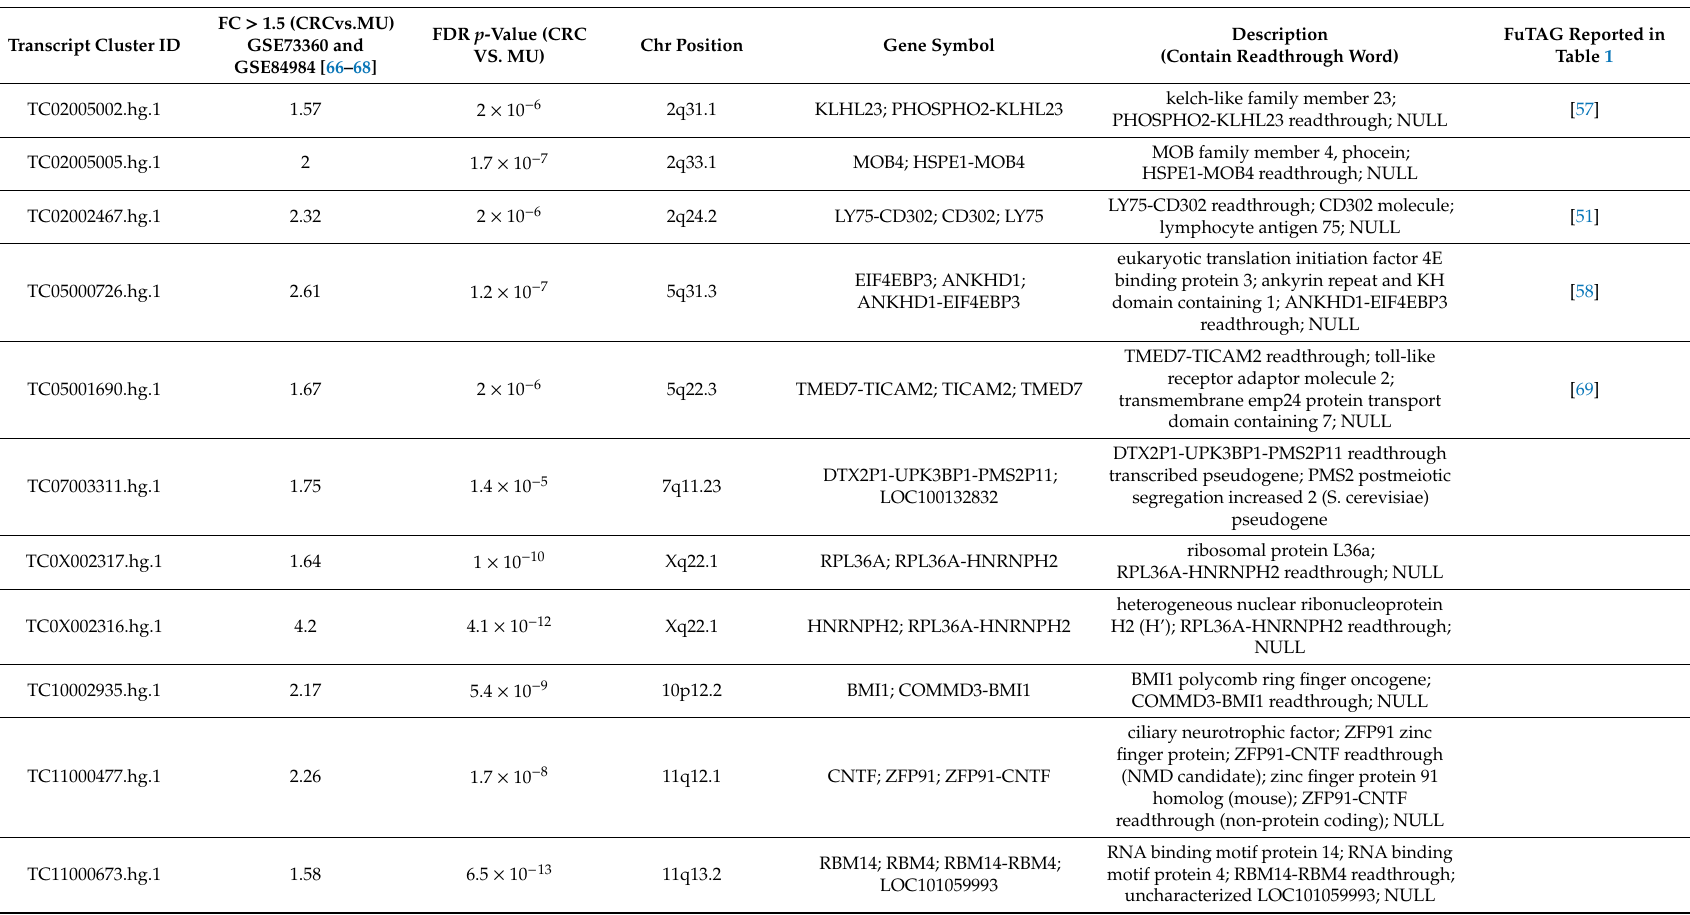
Table 3. FuTAGs located in all chromosomes and upregulated (FC > 1.5) in CRC in comparison to normal mucosa. Data obtained by HTA